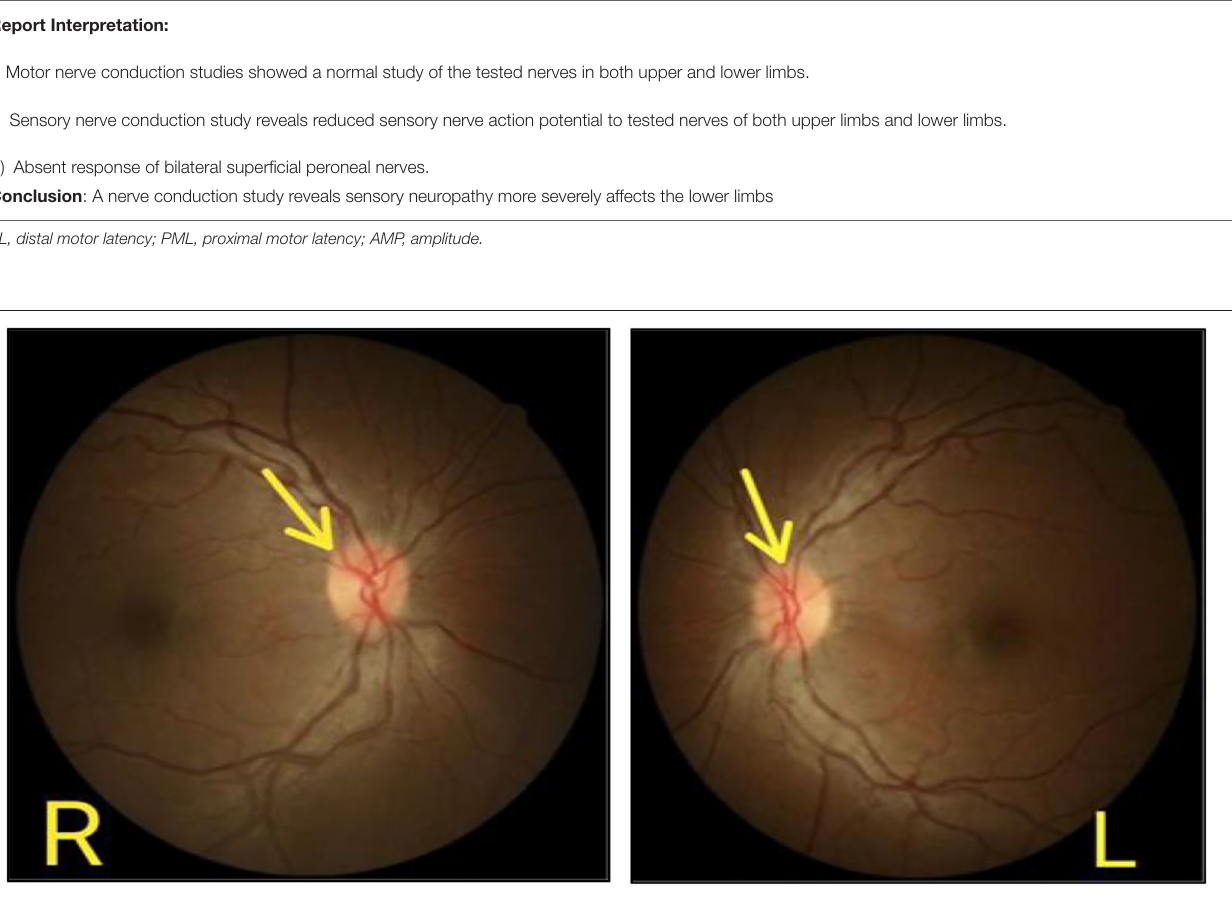
FIGURE 2 | Optic disc edema of right and left